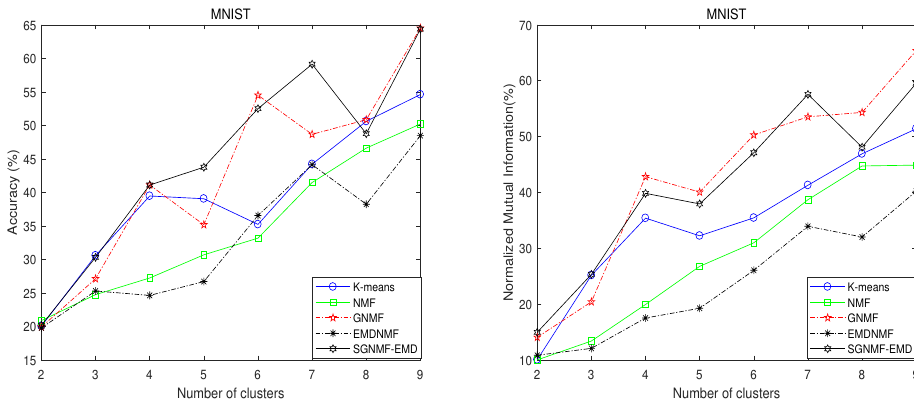
Figure 2. Clustering performance comparisons on the MNIST